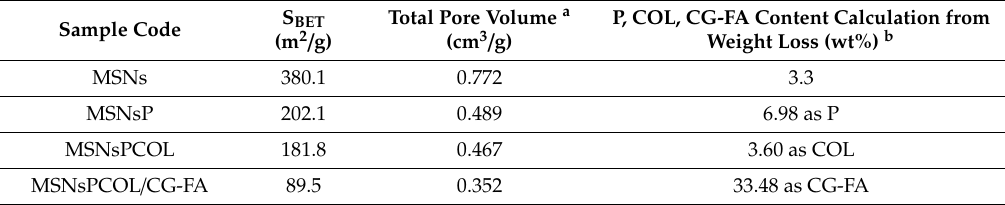
Table 1. Physicochemical properties of MSNs before and after colchicine loading and polymer coating. Sample